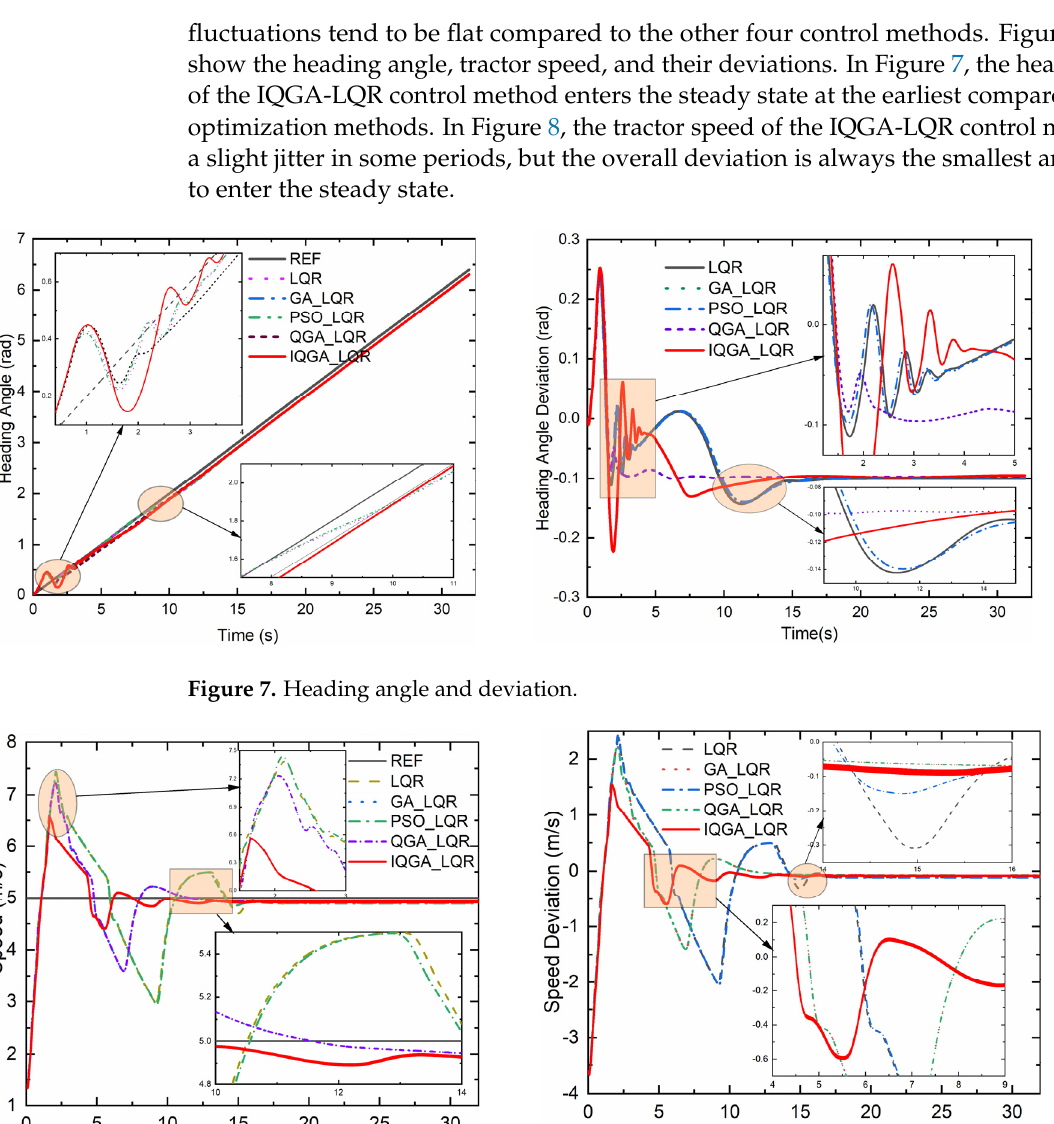
Figure 6. Longitudinal displacement and deviation.